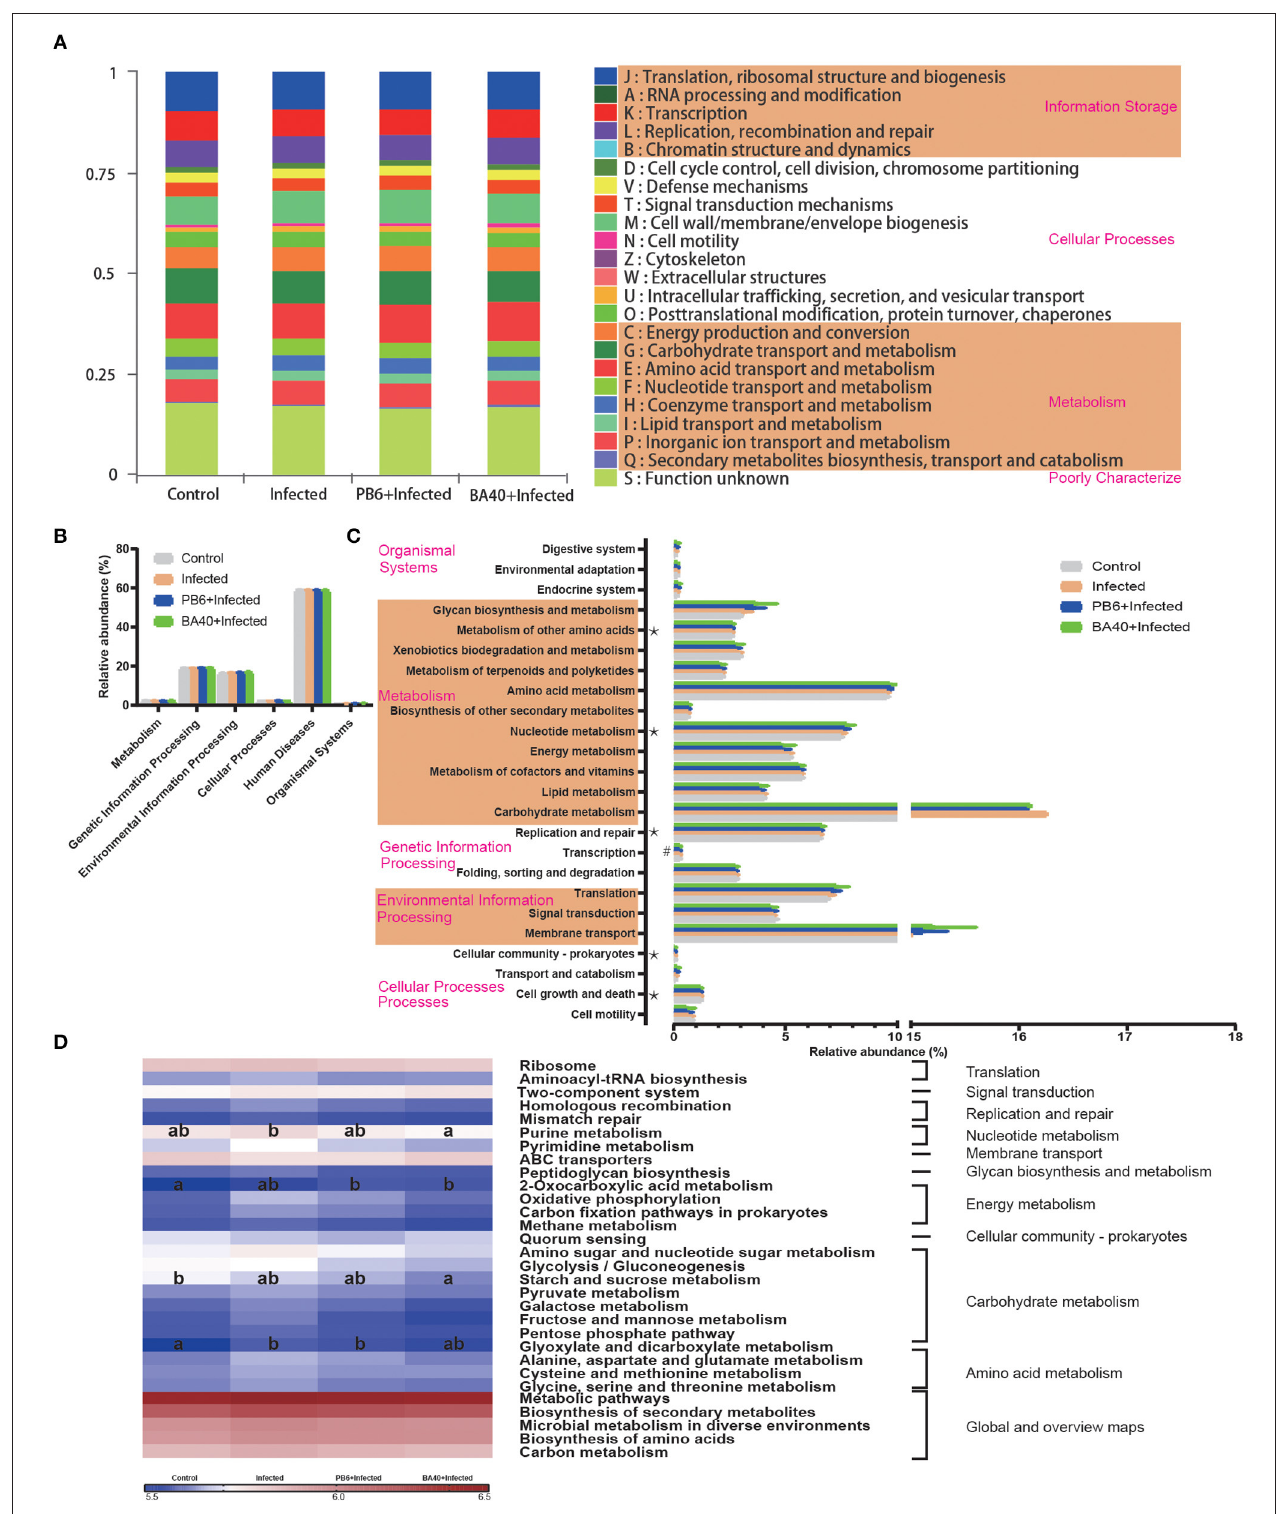
FIGURE 8 | Dynamic of bacterial functional profiles analyzed by PICRUSt ( n = 6). (A) Clusters of orthologous groups of proteins (COG) function classification. (B) Metabolic pathways in level 1. (C) Kyoto Encyclopedia of Genes and Genomes (KEGG) ortholog functional predictions (Level 2). (D) KEGG ortholog functional predictions of the relative abundances of top 30 metabolic functions (Level 3). *Means P < 0.05 for BA40 vs. Control and # P < 0.0 5 for BA40 vs. PB6. a,b Means with a row with different superscripts significantly differ ( P < 0.05).